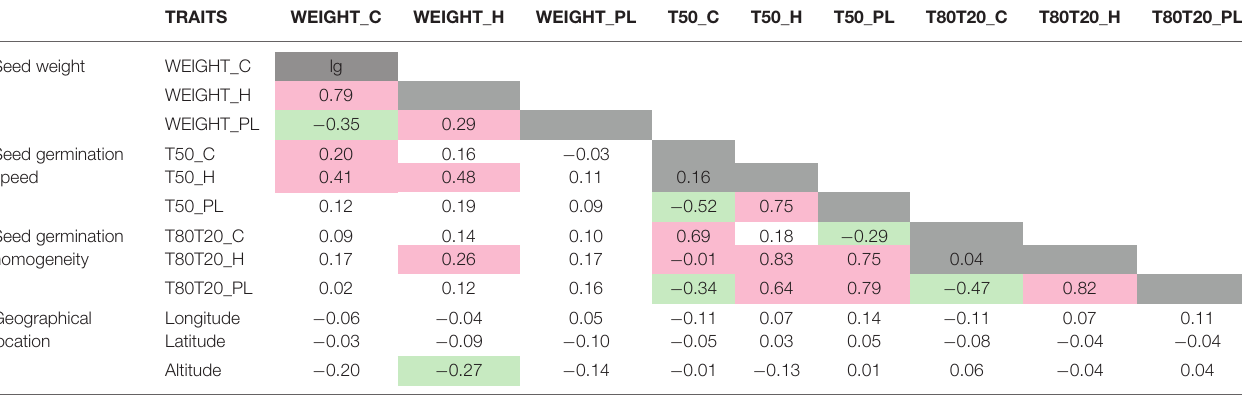
TABLE 1 | Correlation matrix between all Medicago seed traits and climatic data.